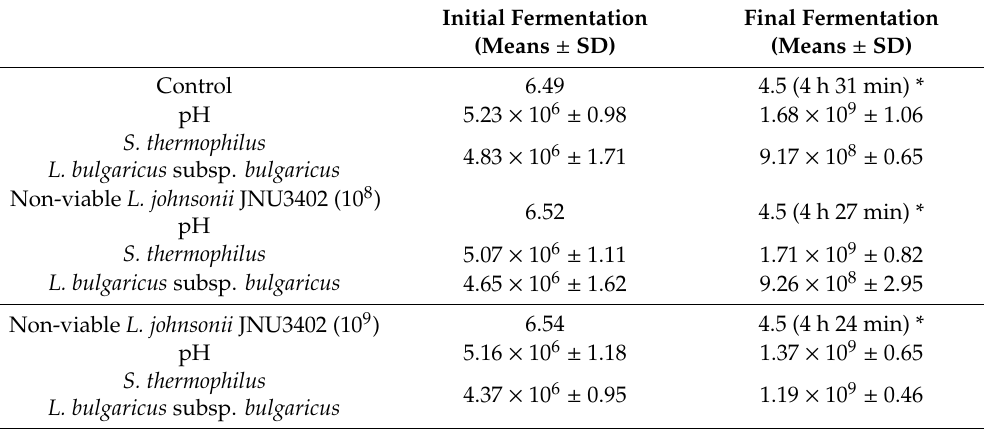
Table 2. Changes of the pH value and the viable cells of lactic acid bacteria in yogurt